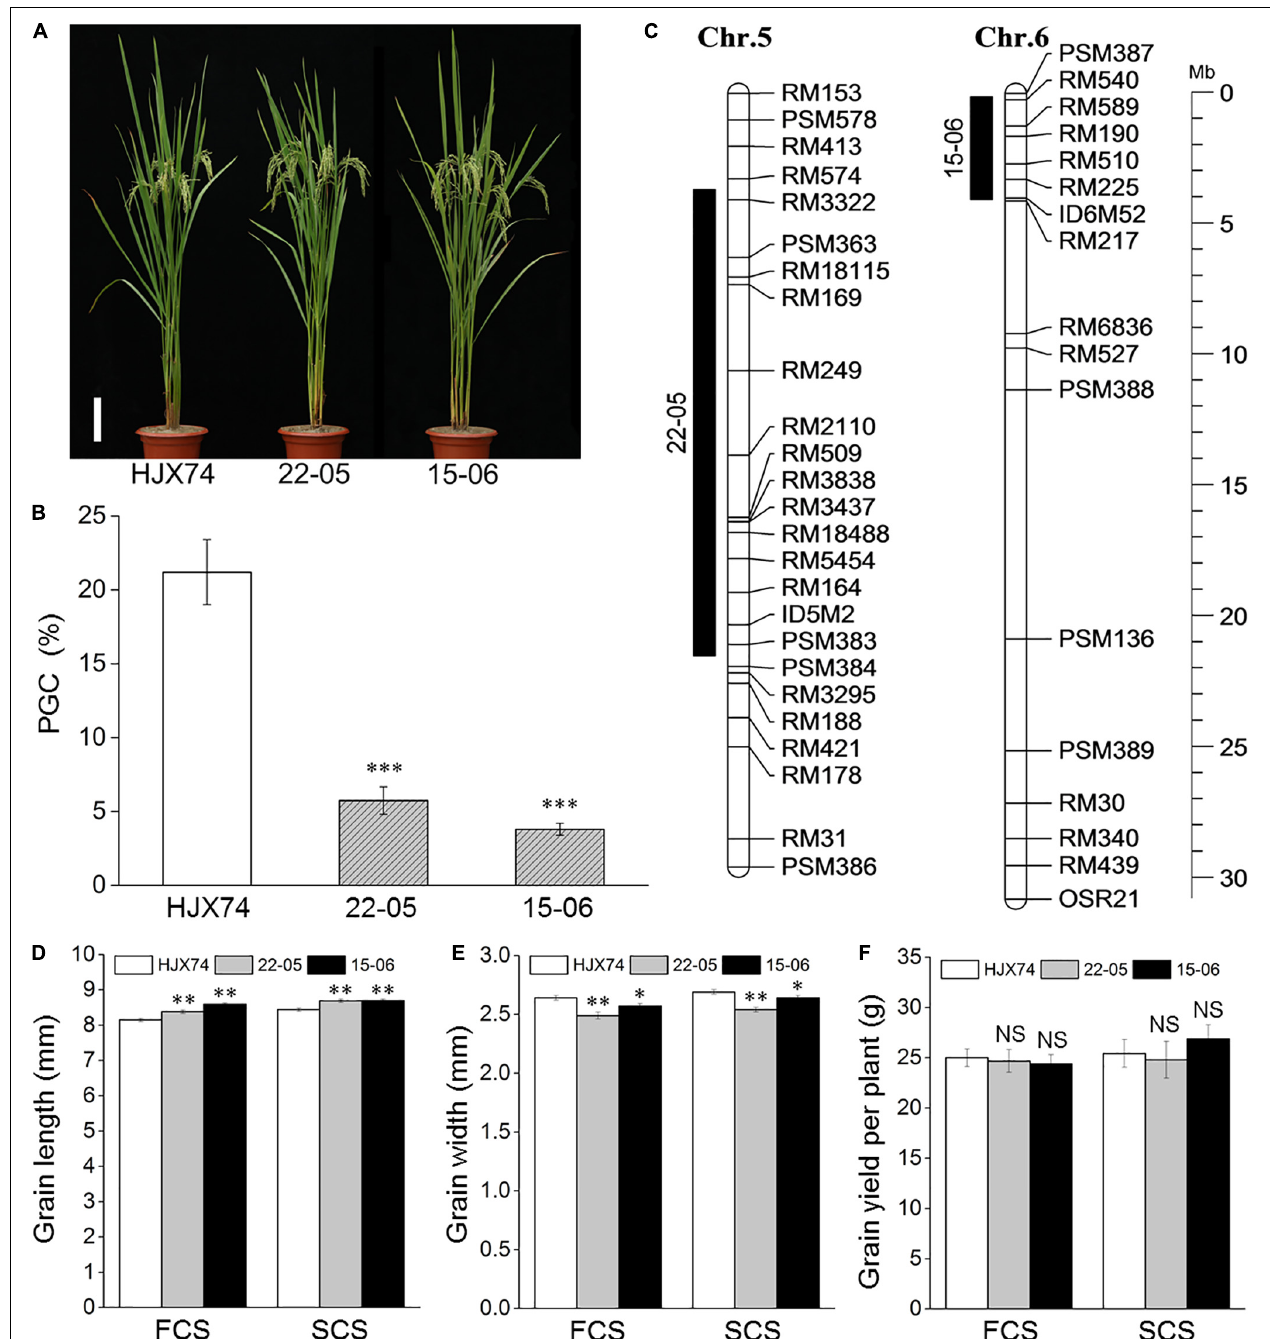
FIGURE 1 | Phenotypes and substitution segments of two SSSLs. (A) Plant type of SSSLs 22–05 and 15–06 and control HJX74. Scale bar, 15 cm. (B) Percentage of grain chalkiness (PGC) of SSSLs and control HJX74. PGC is shown as mean ± S.E. in six cropping seasons. (C) Substitution segments of SSSLs 22–05 and 15–06. Black bars on the left of chromosomes represent the substitution segments of SSSLs. Physical distance is shown on the ruler. Chr., Chromosome. Mb, Megabase. The grain length (D) , grain width (E) and grain yield per plant (F) of SSSLs 22–05 and 15–06 and control HJX74 are shown as mean ± S.E. FCS, First cropping season; SCS, Second cropping season. ∗ , ∗∗ and ∗∗∗ , Significant difference at the 0.05, 0.01, and 0.001 levels, respectively. NS, No significance.